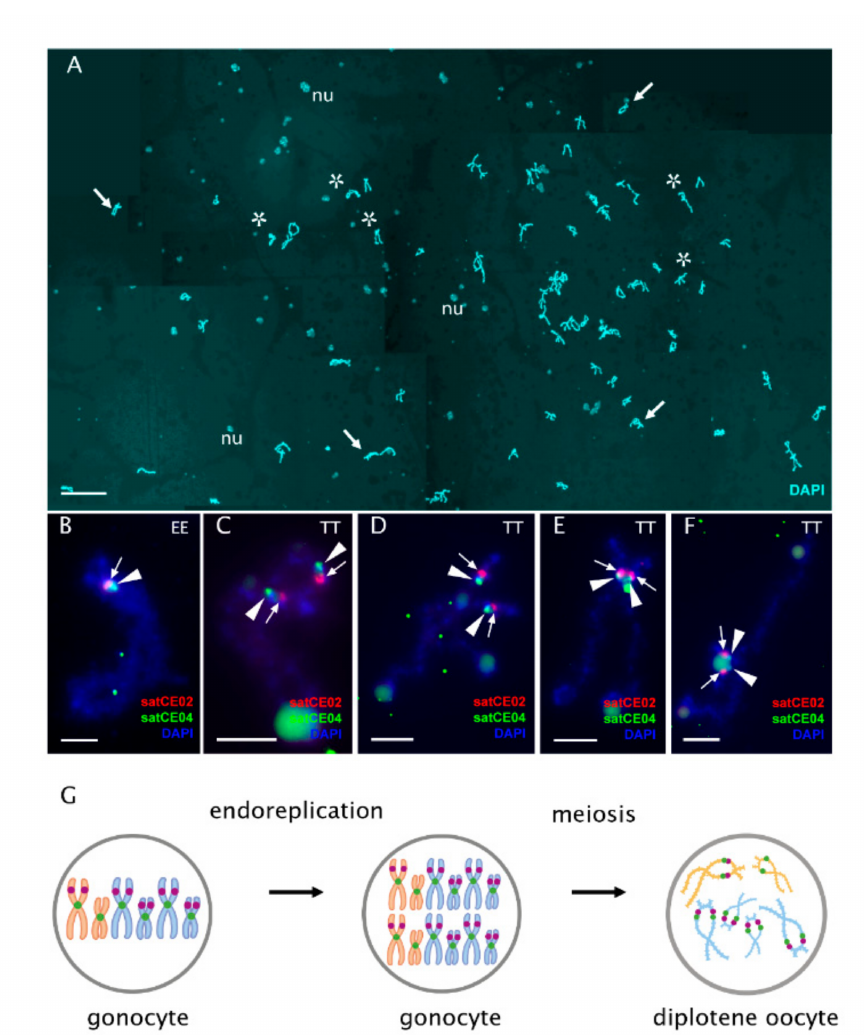
Figure 3. FISH-based identification of bivalents from diplotene oocyte of triploid ETT female. ( A ) Full diplotene chromosomal spread from the individual oocyte including 73 bivalents stained with DAPI (cyan). Thick arrows indicate examples of individual bivalents; nu shows examples of extrachromosomal nucleoli. Since the chromosomal spread from the individual oocyte was large, five images were taken and merged into one. Asterisks indicate enlarged bivalents represented on ( B – F ) panels. Scale bar = 50 µ m. ( B – F ) High-resolution mapping of species polymorphic (satCE02, red; indicated by arrows) and centromeric markers (satCE04, green; indicated by arrowheads) on individual bivalents. Using the combination of two markers and bivalent morphology, a bivalent of C. elongatoides ( B ) and 4 bivalents of C. taenia ( C – F ) were identified. Scale bar = 5 µ m. ( G ) Schematic representation of gametogenic pathway in triploid ETT hybrids with the indication of karyotype composition in gonocytes and diplotene oocytes. Only hexaploidy oocytes were observed during diplotene. Premeiotic endoreplication was suggested to form duplicated numbers of chromosomes in diplotene oocytes. C. elongatoides chromosomes depicted in orange; C. taenia chromosomes depicted in blue. Purple and green marks indicate chromosomes identified by FISH with species polymorphic marker satCE02 and centromeric marker satCE04,